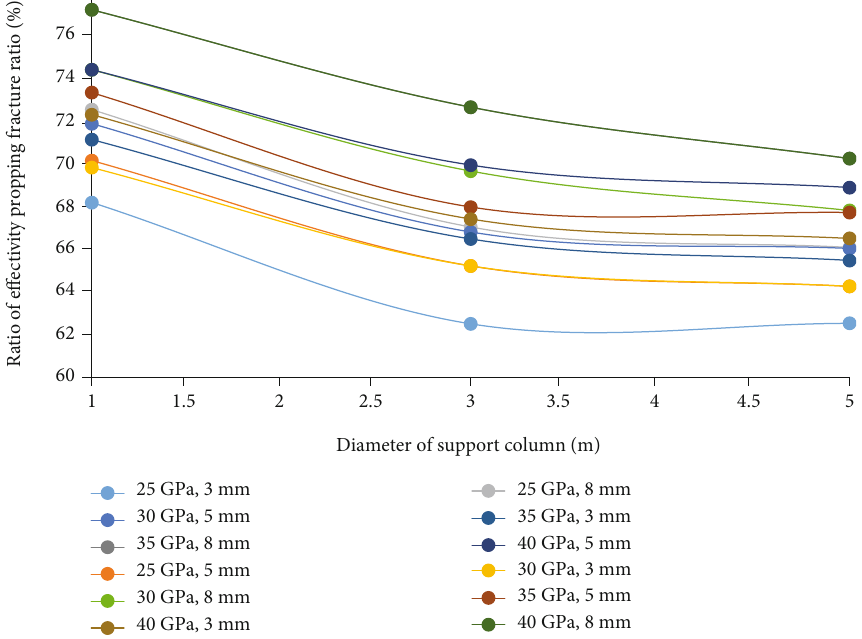
Figure 46: The in fl uence of proppant diameter on the ratio of e ff ective supporting fractures (in situ stress